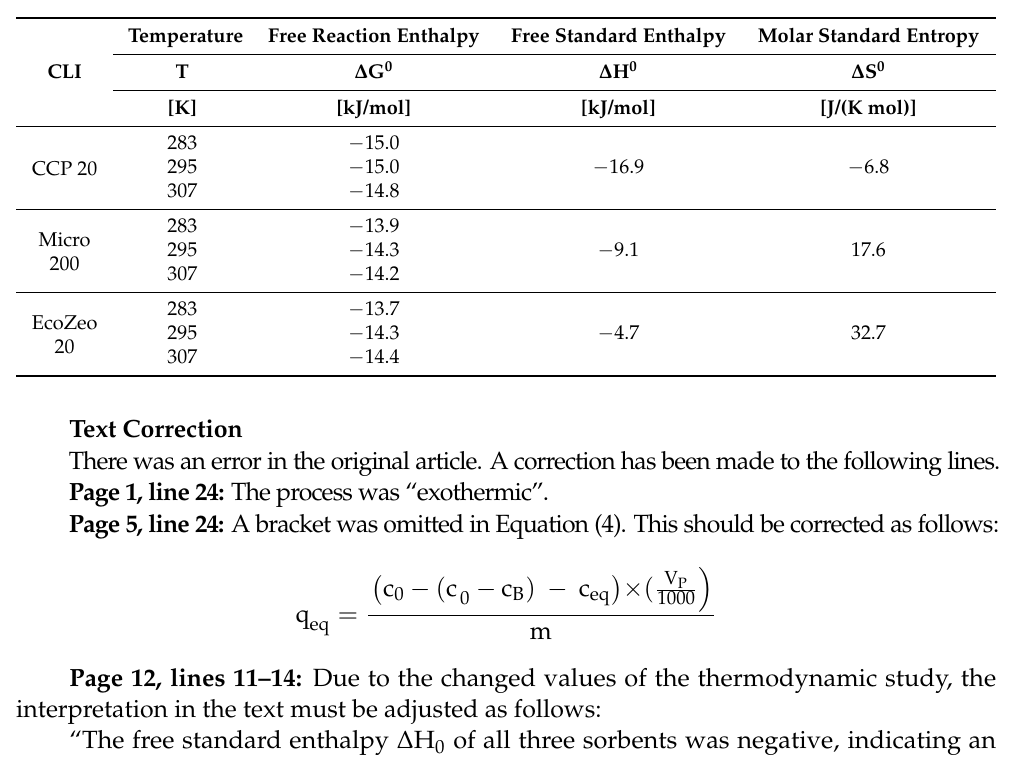
Table 7. Thermodynamic properties of CCP 20, Micro 200, and EcoZeo 20 after 20 h contact time